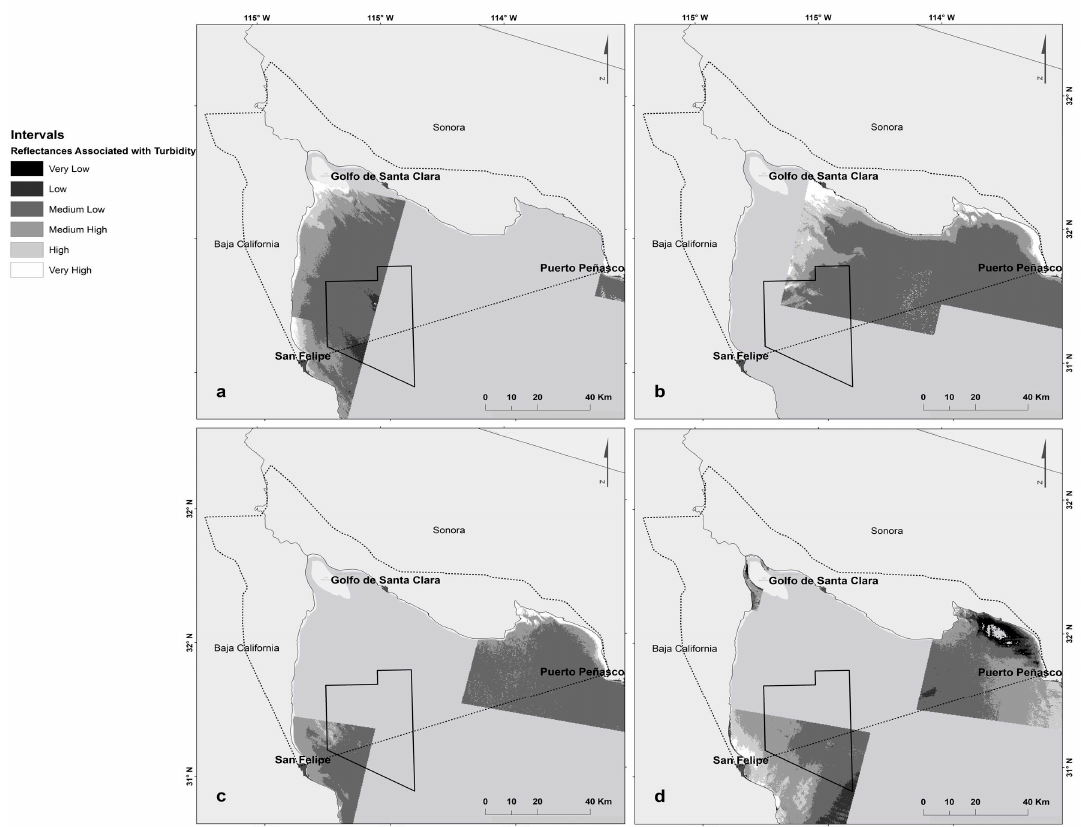
Figure 2. Upper Gulf of California (UGC) maps of turbidity for the year 2010 in ( a ) cold season, spring tide in flow; ( b ) cold season, neap tide in ebb flow; ( c ) cold season, neap tide in flow and ( d ) warm season, spring tide in flow. The Biosphere Reserve area and the Vaquita marina refuge polygons are